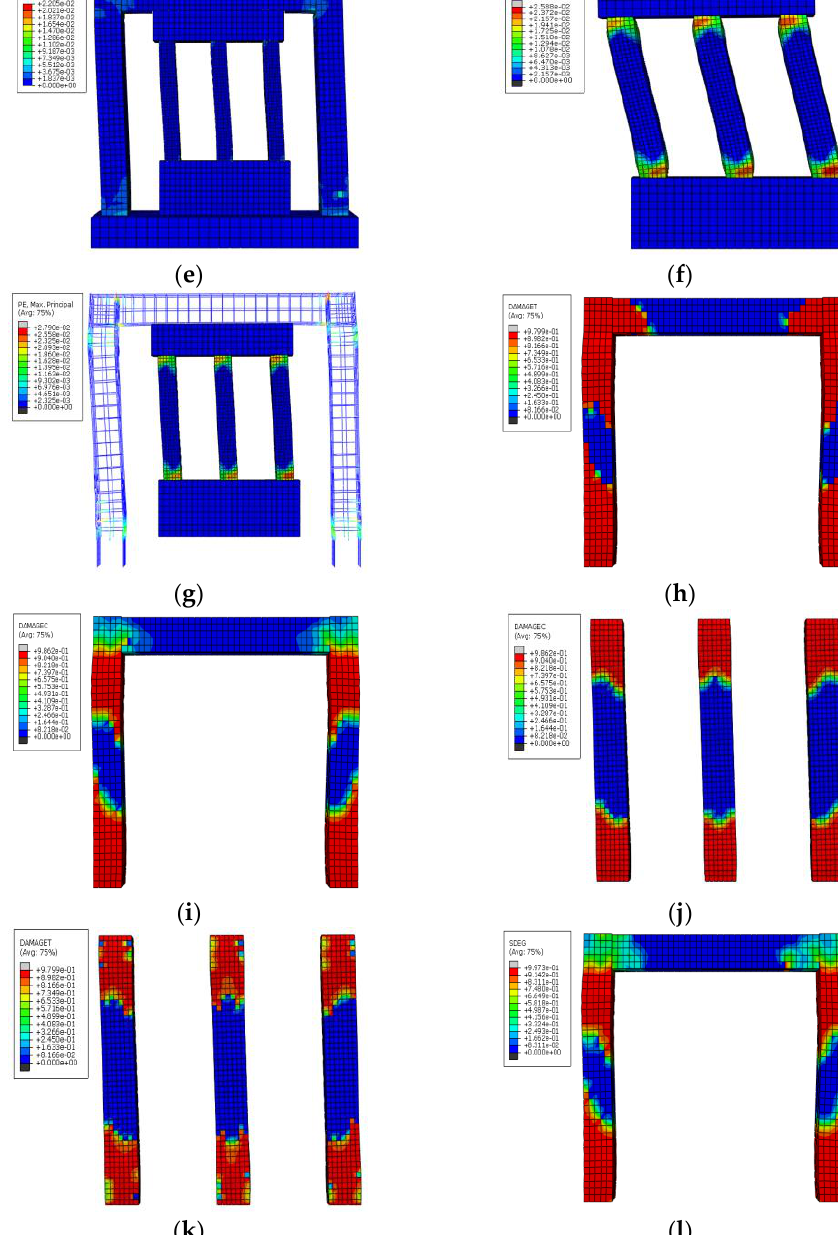
Figure 6. Failure process and failure form of GJ-1. ( a ) The first concrete plastic strain element at the beam end; ( b ) the first concrete plastic strain element of column foot; ( c ) development stage of beam and column cracks; ( d ) the beginning of the yield stage of energy dissipation device; ( e ) the crack development stage at the end of beam and column at the yield stage; ( f ) the yield stage of energy dissipation device; ( g ) stress cloud chart of reinforcement at the yield of frame column end; ( h ) cloud chart of frame tension failure; ( i ) cloud chart of frame compression failure; ( j ) cloud chart of concrete compression failure inside steel pipe; ( k ) cloud chart of concrete tension failure inside steel pipe; ( l ) cloud chart of frame stiffness degradation.